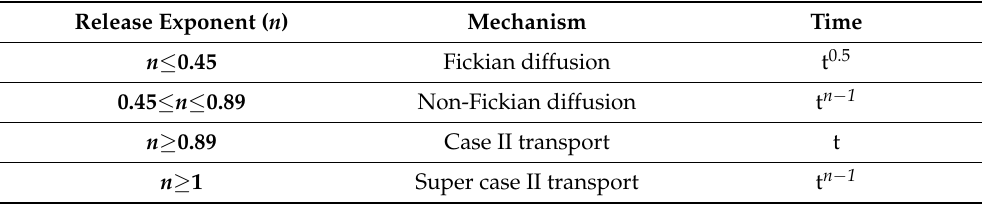
Table 5. The exponent of release ( n ) values and drug-release mechanisms. Release Exponent ( n ) Mechanism Time n ≤ 0.45 Fickian diffusion t 0.5 0.45 ≤ n ≤ 0.89 Non-Fickian diffusion t n − 1 n ≥ 0.89 Case II transport t n ≥ 1 Super case II transport t n −